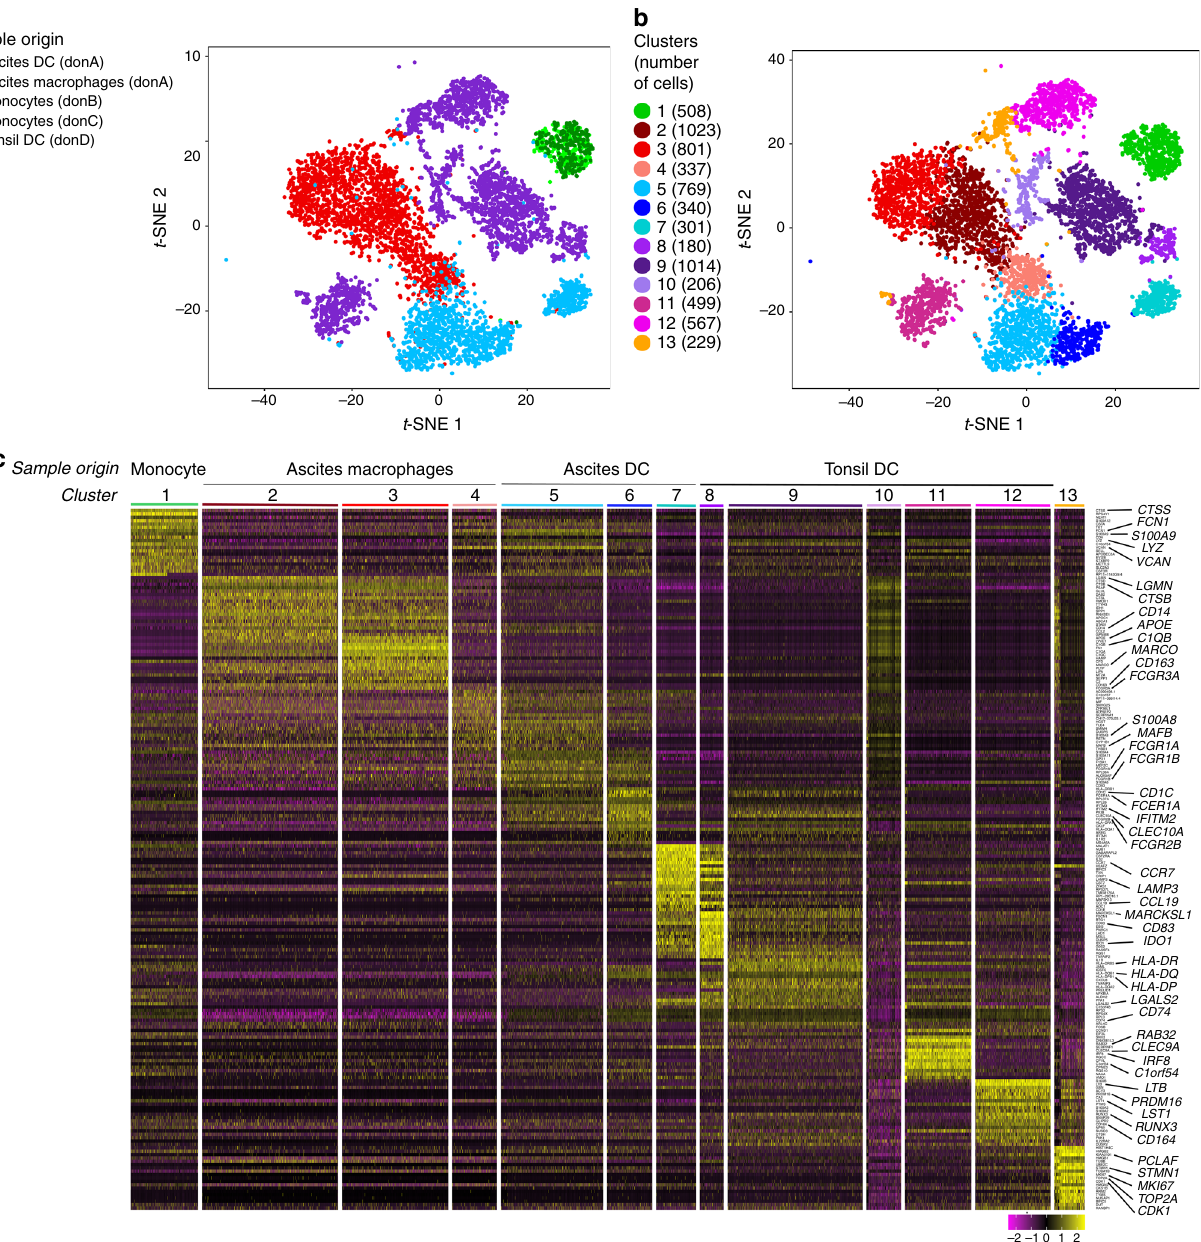
Fig. 1 Ascites DCs are distinct from classical DCs. Puri fi ed ascites DCs, ascites macrophages, tonsil DCs, and blood monocytes were analyzed by single-cell RNA-seq using a Drop-seq approach. Combined single-cell transcriptomes were analyzed. a , b t -SNE representation of cell clusters identi fi ed using unsupervised clustering. Each dot represents an individual cell. a Colors represent sample origin; don donor. b Colors represent identi fi ed clusters. Clusters are manually ordered and cell numbers for each cluster is indicated. c Heatmap of scaled expression (log values of UMI) for the top 20 differentially expressed genes of each cluster (based on log fold